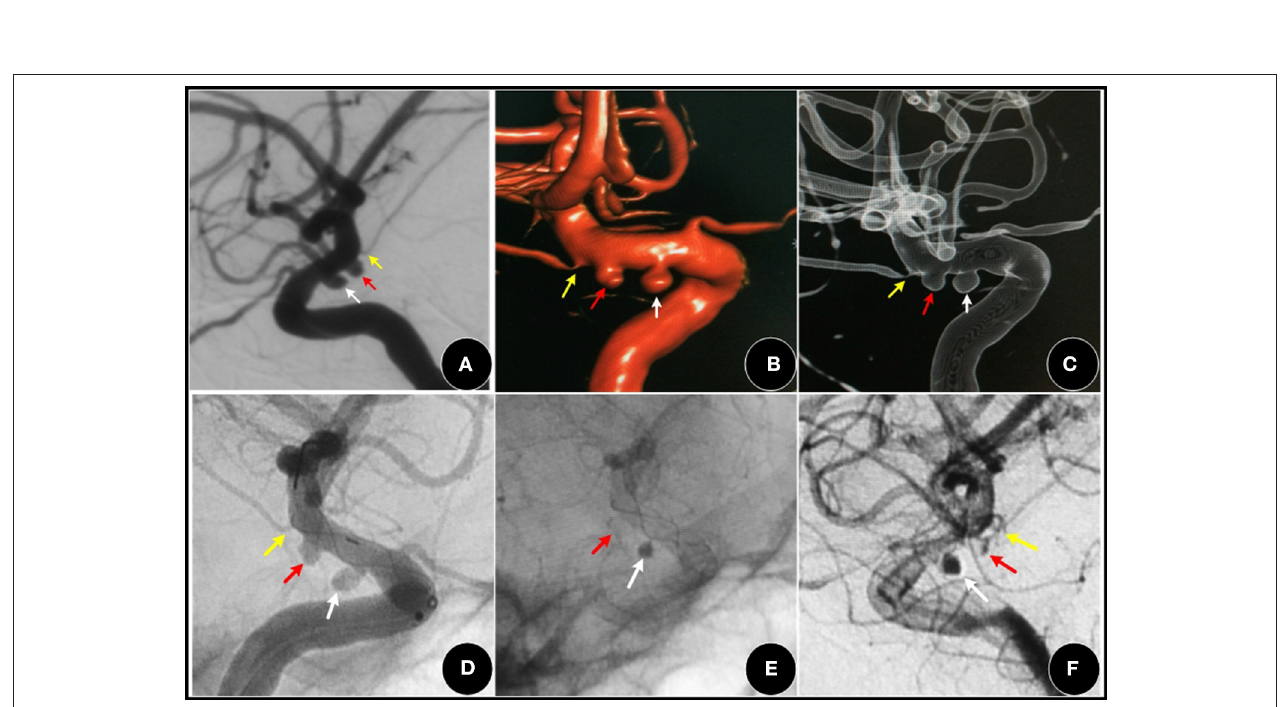
FIGURE 4 | A 52-year-old female, with a three-month history of dizziness. (A–C) showing a I type aneurysm (red arrow) and an adjacent PCA aneurysm (white arrow). (D–F) two aneurysms were covered by an FD (Tubridge stent), the AChoA aneurysm was barely visible (red arrow). The PCA aneurysm (white arrow) showed obvious retention of contrast media, while the AChoA (yellow arrow) was